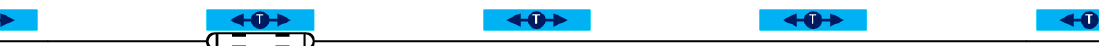
Figure 9. Sharing a section of a tram route by two sample tram lines. Application of a bi-directional tram offers new possibilities, and its potential may be used to mitigate the limitations identified above. Application of a bi-directional tram elim- inates the need for trams to turn around at a tram loop and provides a possibility of plac- ing a switch-back terminal directly on the tram route, which makes it possible to diversify the routing of the individual tram lines on the shared sections of the route. In this case, one tram line may serve the route up to the terminus located at the tram loop (Tram Line No. 1, marked in red in Figure 10), whereas the other tram line may serve up to the termi- nus located at the switch-back terminal (Tram Line No. 2, marked in green in Figure 10).